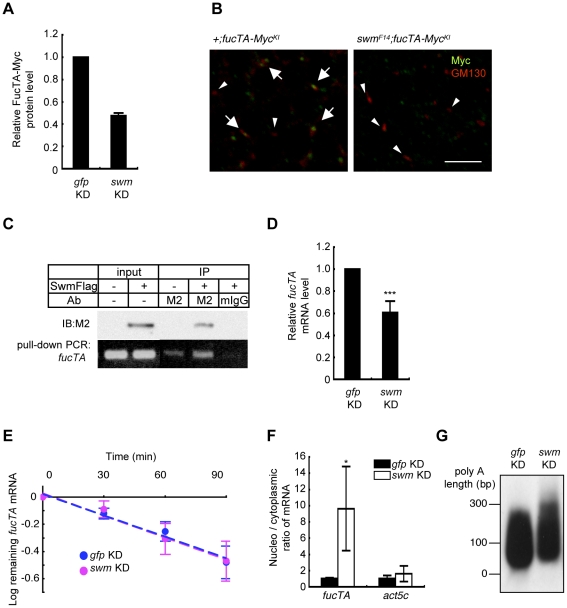
Swm regulation of expression and nuclear export of fucTA mRNA.(A) Quantification of FucTA-Myc in control (gfp KD) and swm (swm KD) knockdown eyes. In this figure, all results shown in graphs are the mean ± SD, n = 2. (B) Expression of FucTA-Myc in the Golgi complex was reduced in swmF14 mutants. FucTA-Myc (green) was well colocalized to the Golgi detected by anti-GM130 (red) in control eyes (arrows, +;fucTA-MycKI). In contrast, FucTA-Myc was hardly colocalized to the Golgi (arrowheads) in swm mutants (swmF14; fucTA-MycKI). Scale bar: 10 µm. (C) In vivo binding of Swm and endogenous fucTA mRNA. Endogenous fucTA mRNA was immunoprecipitated with an anti-Flag antibody (M2) from BG2-c6 cells expressing Swm-Flag and detected by RT-PCR (bottom). Control experiments were performed without Swm-Flag expression (−) or by immunoprecipitation with a mouse IgG antibody (mIgG). (D) Decrease of fucTA mRNA in swm knockdown BG2-c6 cells. Levels of fucTA RNA in swm knockdown cells was normalized to that in control gfp knockdown cells, n = 3. ***p<0.005. (E) Decay of fucTA mRNA in swm knockdown BG2-c6 cells. Levels of fucTA mRNA at each time point after actinomycin D addition were normalized to those at time 0, n = 3. (F) Ratios of fucTA and actin (act5c) mRNA levels in nuclear vs. cytoplasmic fractions in swm knockdown BG2-c6 cells were normalized to those in control gfp knockdown cells. n = 4. (G) PolyA length of fucTA mRNA in swm knockdown BG2-c6 cells. PolyA of fucTA was amplified by PCR and detected by Southern blotting with a probe corresponding to fucTA.